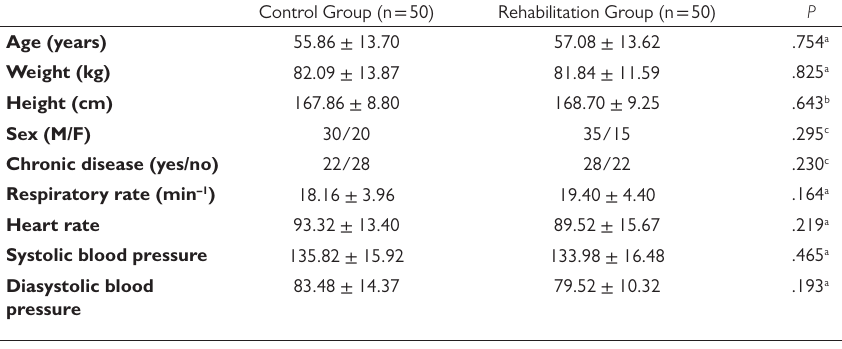
Table 1. Demographic Characteristics of Study Patients